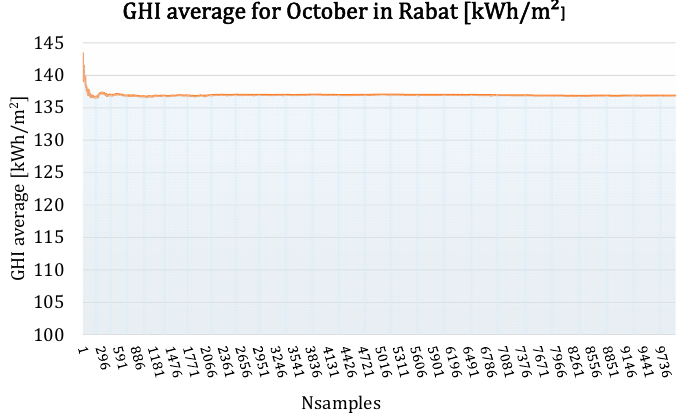
Figure 14. Evolution of the GHI average for October in Rabat according to the number of samples obtained in the Monte Carlo simulation. Source: own elaboration.